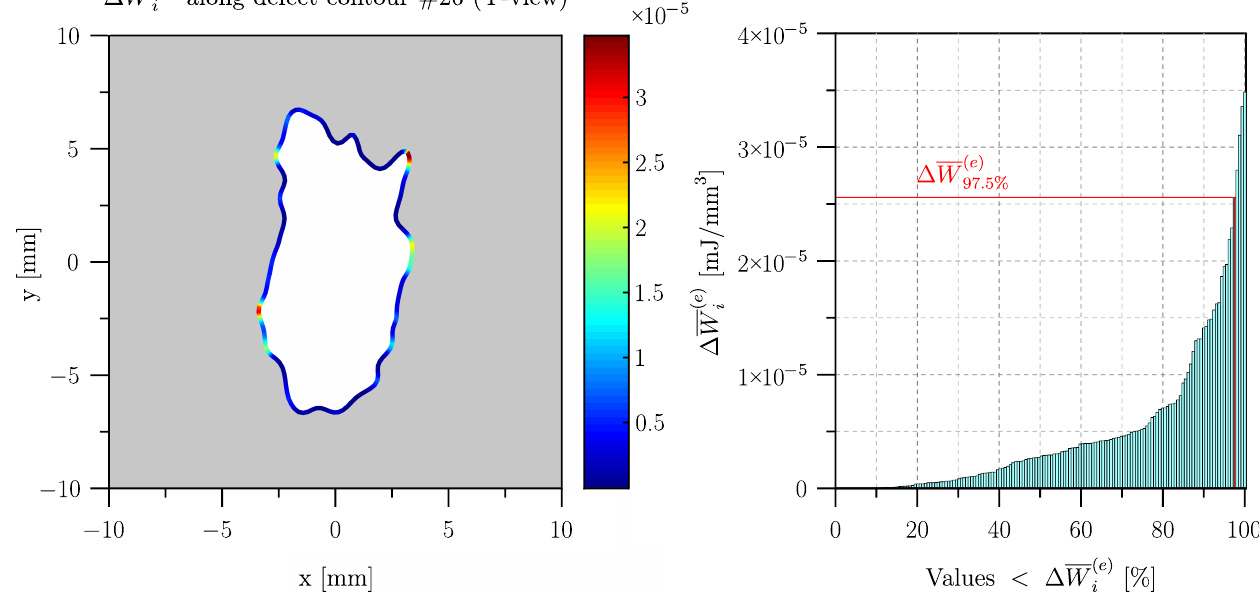
( e ) exemplified on the Y-view of specimen 97.5%